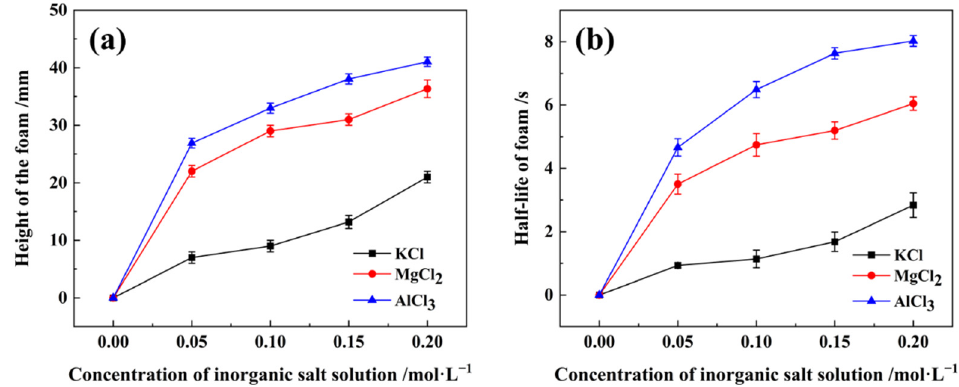
Figure 8. The effect of inorganic salt concentration on ( a ) foam height and ( b ) foam half-life.